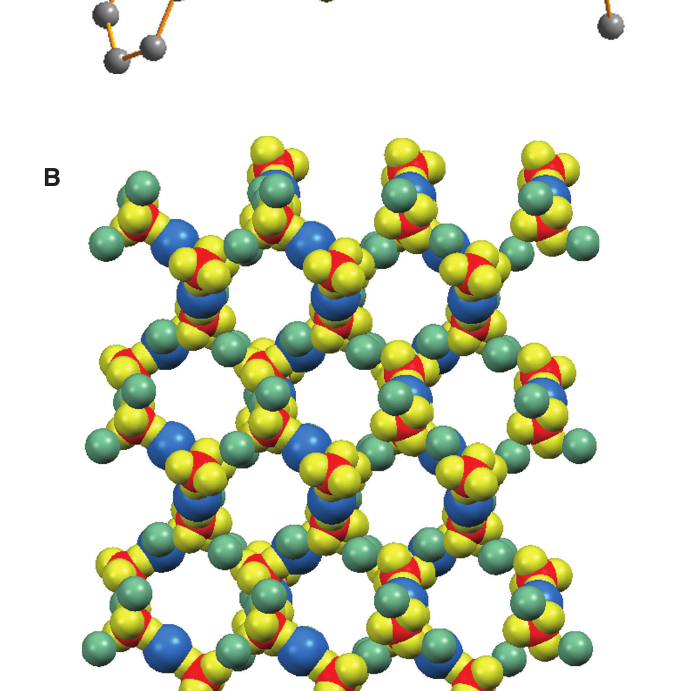
Figure 2 Crystal packing of 1 through intermolecular NH···O hydrogen bonds. (A) Representation of the trinuclear macrocyclic ring [Hydrogen atoms were omitted for clarity. Hydrogen bonding interactions are shown by dashed lines: N1H···O3 = 2.781(18) Å, N1H···O6 = 2.757(17) Å, N2H···O4 = 2.70(2) Å, N2H···O8 = 2.761(18) Å, N3H···O2 = 2.749(17) Å, N3H···O7 = 2.733(18). Mercury view]. (B) Space-fill representation of the resulting three-dimensional supramolecular porous framework. Hydrogen and carbon atoms were omitted for clarity (Mercury